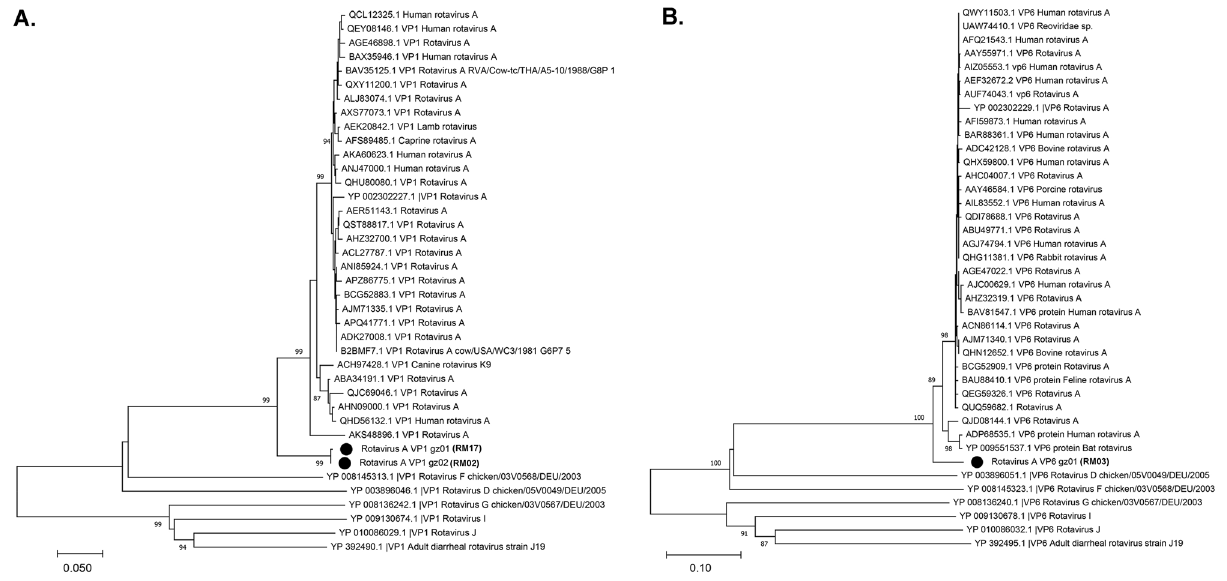
Figure 7. Phylogenetic relationships of vole rotavirus A based on the VP1 (RdRp) protein ( A ) and VP6 protein ( B ). Branch lengths are drawn to a scale of aa substitutions per site. Numbers above individual branches indicate bootstrap support, only values > 80% are shown. Novel rotavirus A variants are marked by a black dot, sample ID were labeled in